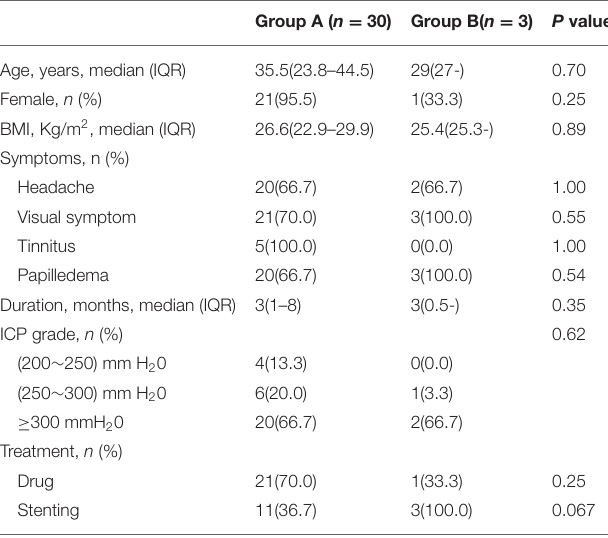
TABLE 4 | Clinical features of different cerebral venous outflow pattern in 33 enrolled patients with